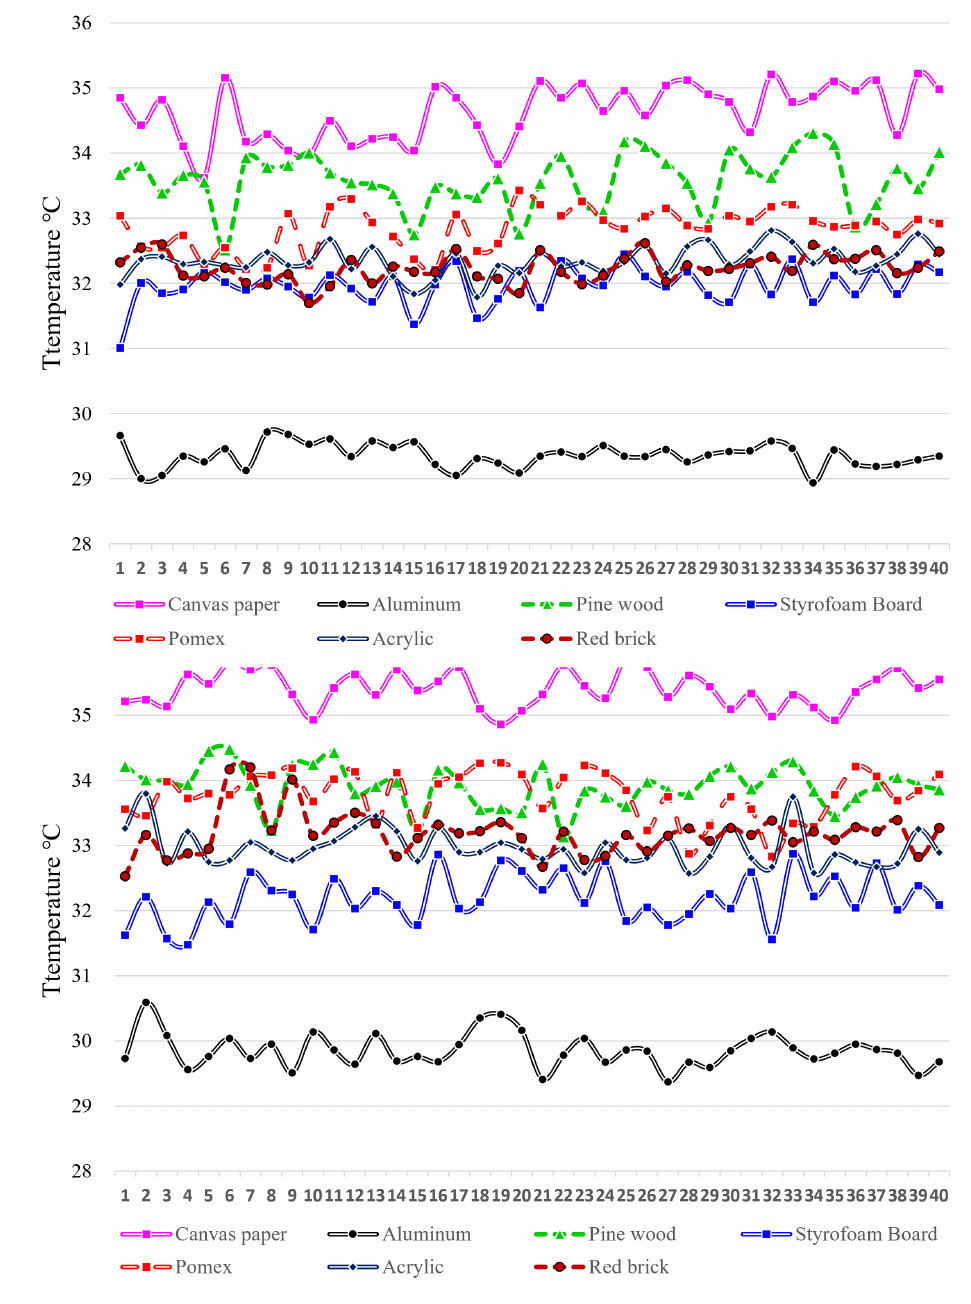
Figure 8. Second experiment hot spot temperature graph for each material. Creation method: top : fingertip, touch, bottom : exhalation using a hollow rod (vertical axis: celsius temperature, horizontal axis: temperature data of